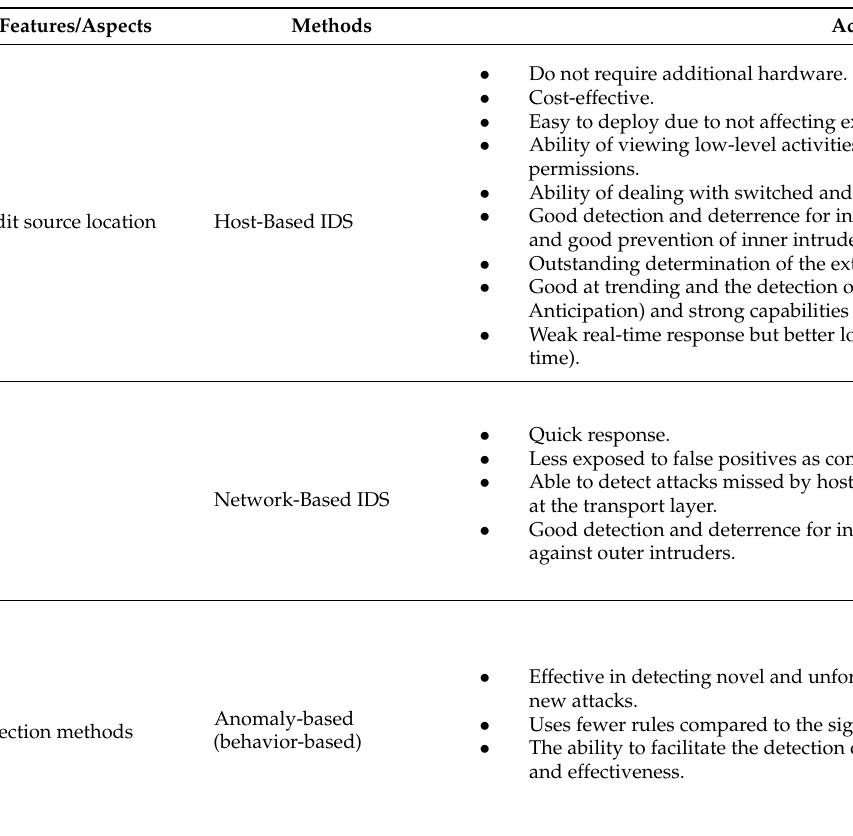
Table 2. Classification of IDS methods based on their aspects, advantages, and